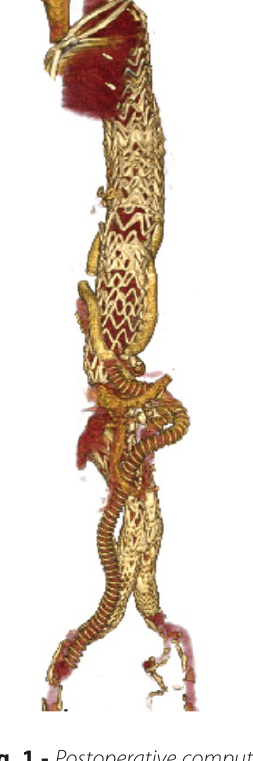
Fig. 1 - Postoperative computed tomography angiography of the